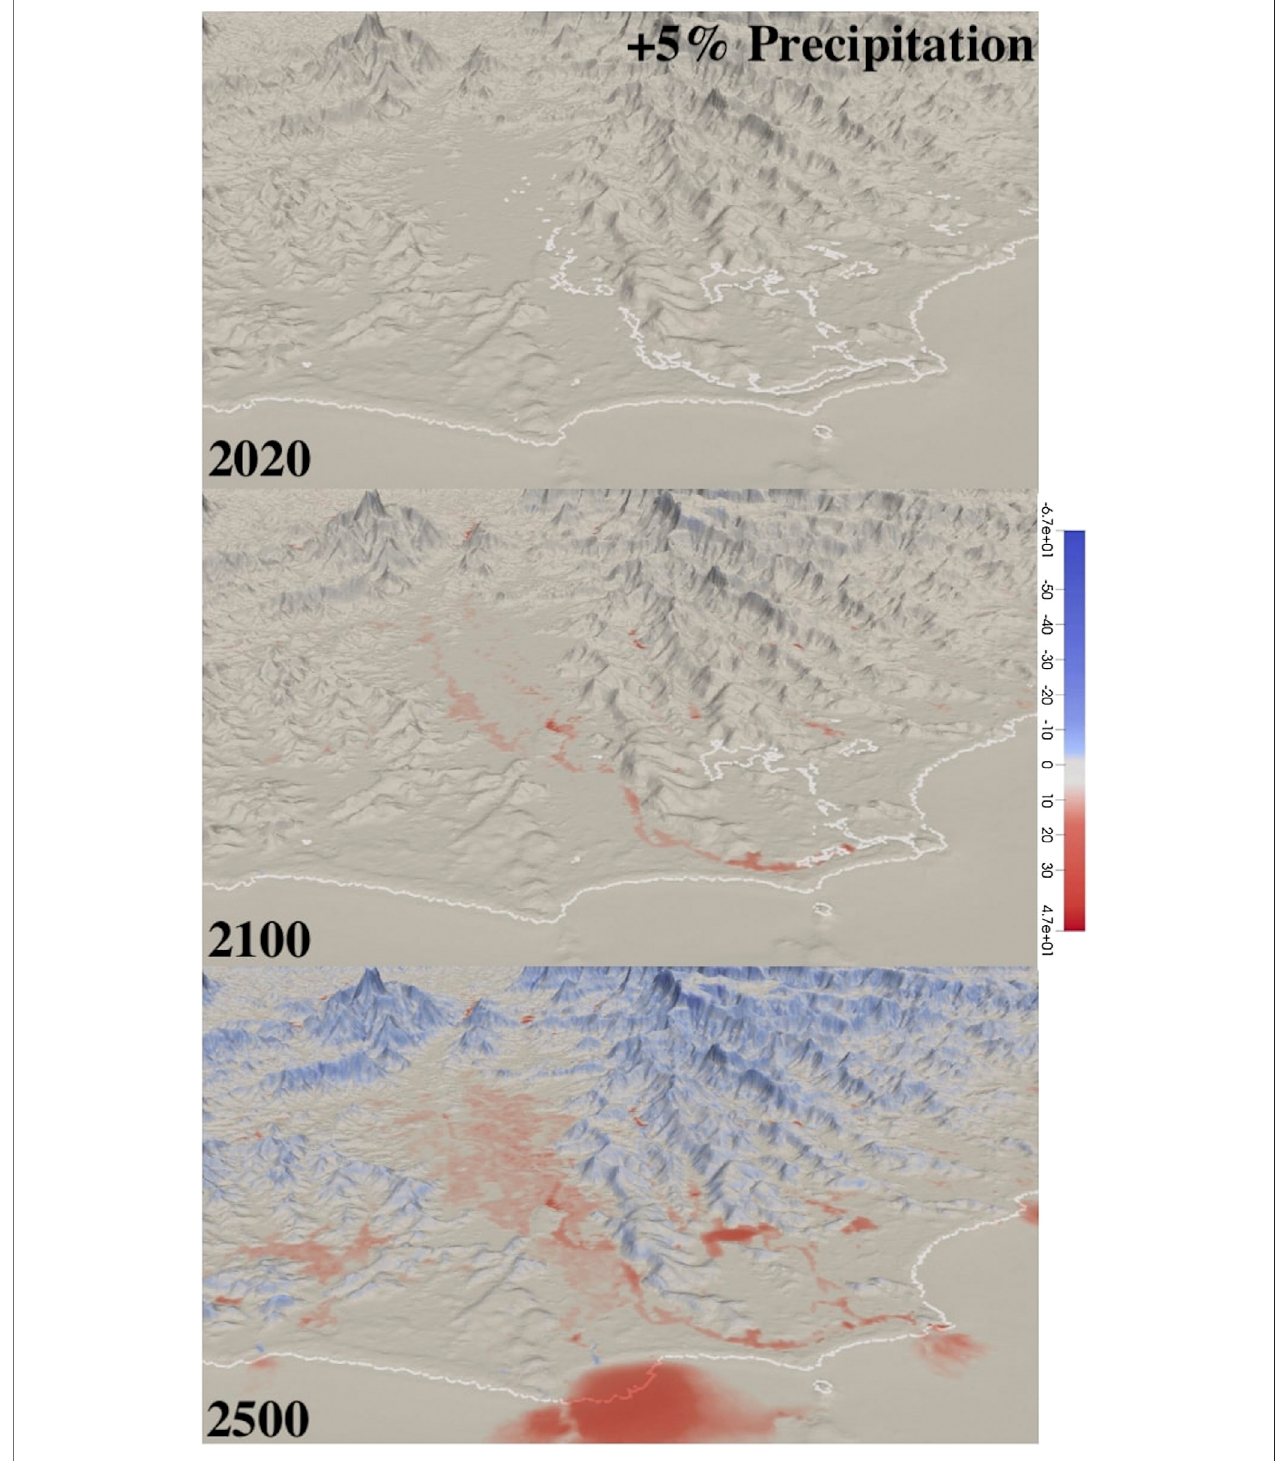
FIGURE 10 | Zoomed in regional visualization of the Tweed Valley fl oodplain region under a 5% increase in precipitation, demonstrating the signi fi cant control sea level rise has on the regional transport of ma fi c sediment. Red areas indicate deposition and blue areas indicate erosion (m 2 /a).